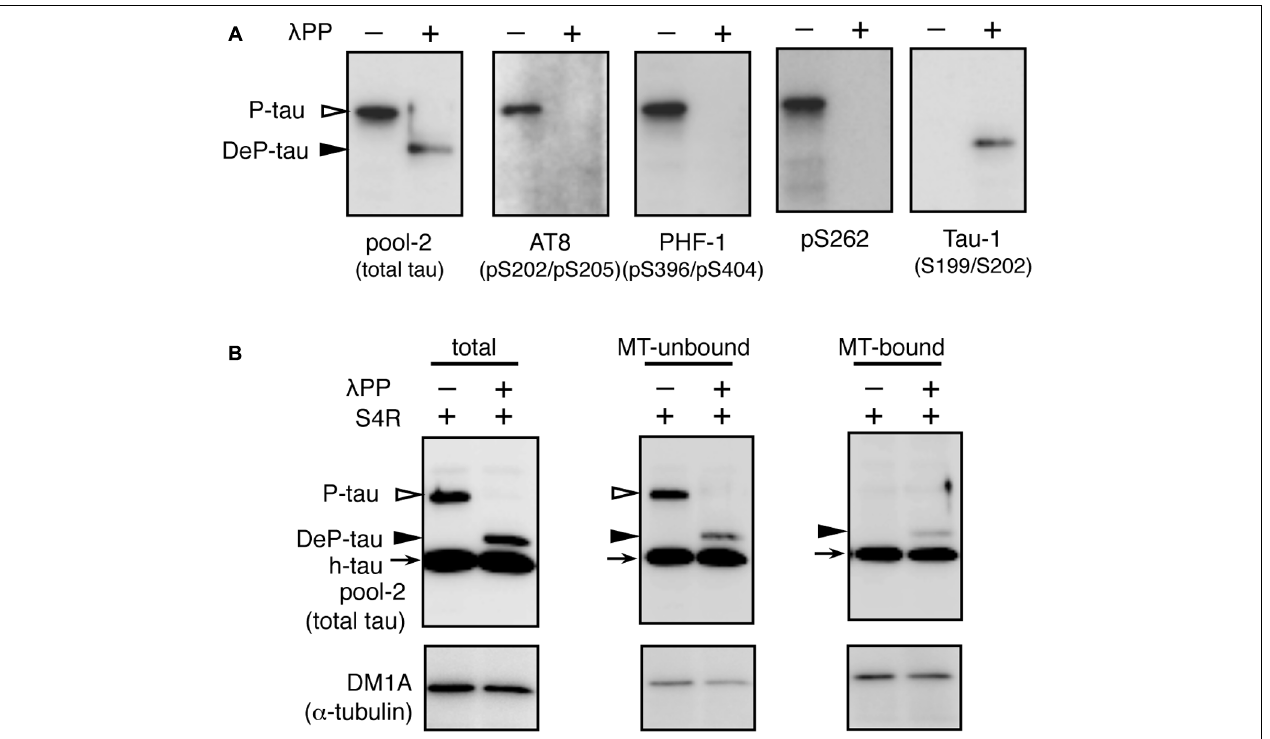
FIGURE 6 | In vitro dephosphorylation restores the MT-binding activity of human-tau in tau-Tg worms. (A) l-phosphatase dephosphorylation of tau in worms was assessed by Western blotting using the indicated antibodies. (B) Purified tau from WT4R(H)-Tg worms were remixed with recombinant human 0N4R tau isoform (h-tau, positive control) and MTs from naive worms (total). MT-unbound and MT-bound fractions were prepared from this mixture as described in the Materials and Methods section. Bands corresponding to phosphorylated tau (P-tau, open arrowheads), dephosphorylated tau (DeP-tau, closed arrowheads), and recombinant tau (h-tau, arrows) are indicated. Note that a portion of dephosphorylated tau, but not phosphorylated tau, was recovered in the MT-bound fraction like recombinant